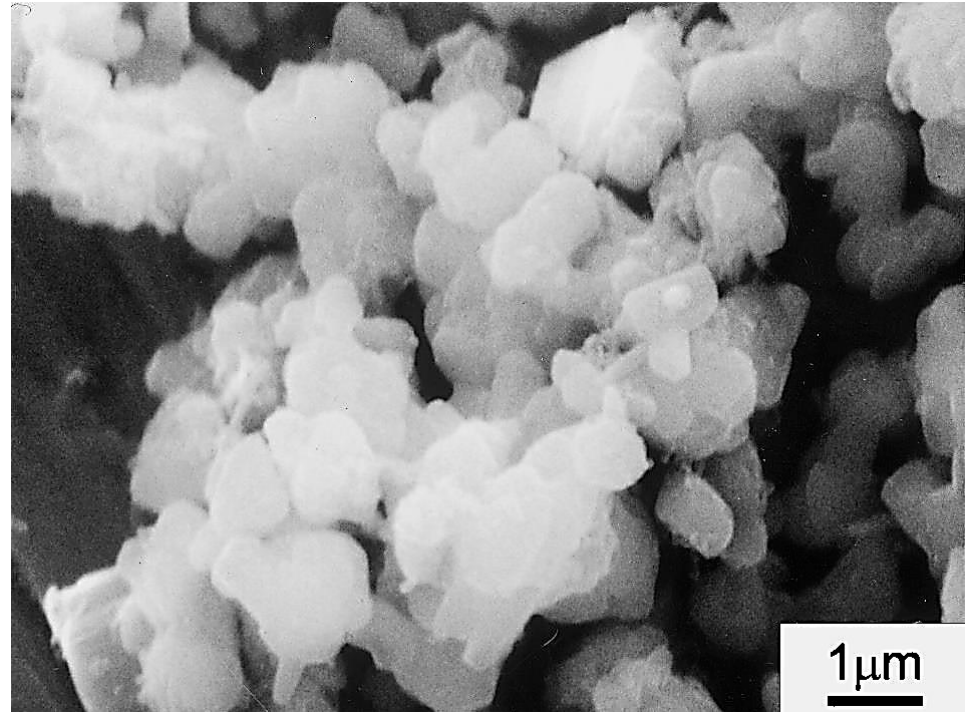
Figure 7. Representative SEM image of a SiAlON microstructure, synthesized from talc and halloysite [62]. Table 2. Use of halloysite in advanced ceramic products.